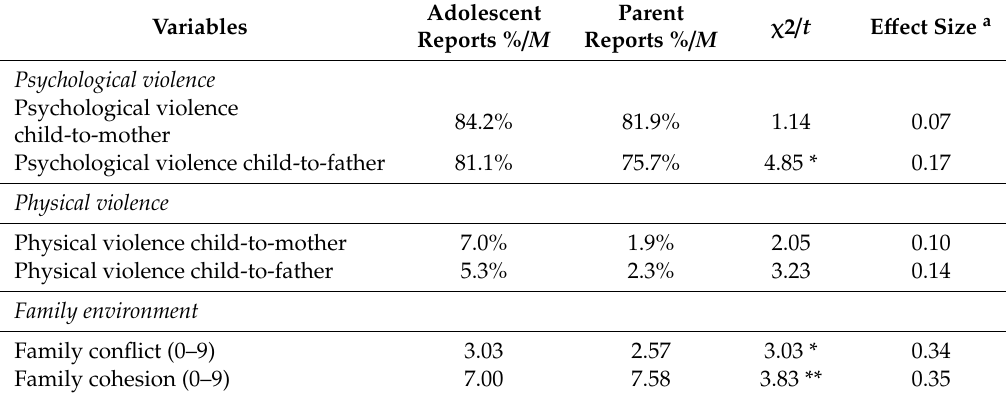
Table 1. Prevalence rates of di ff erent types of child-to-parent violence (CPV) and family environment perception by